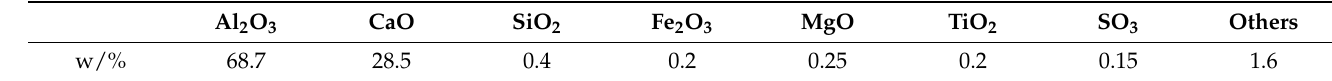
Table 1. Chemical composition of